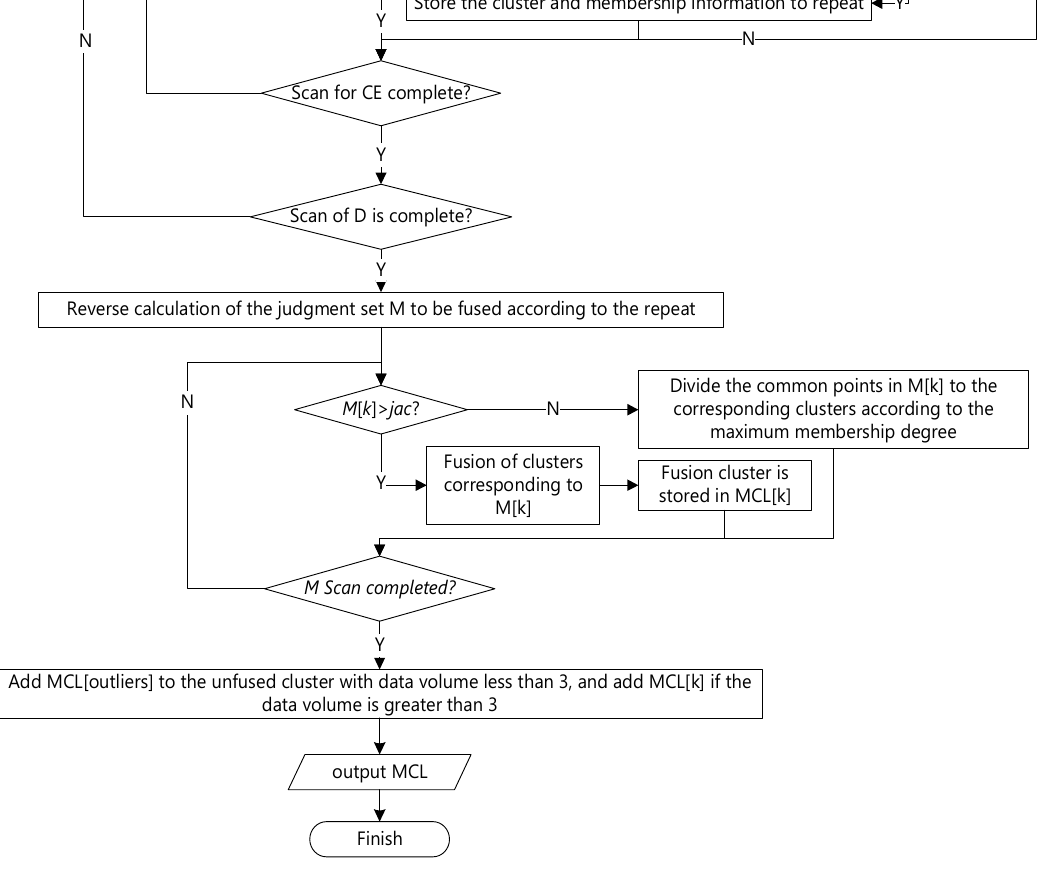
Figure 2. PRI-MFC algorithm flow chart.